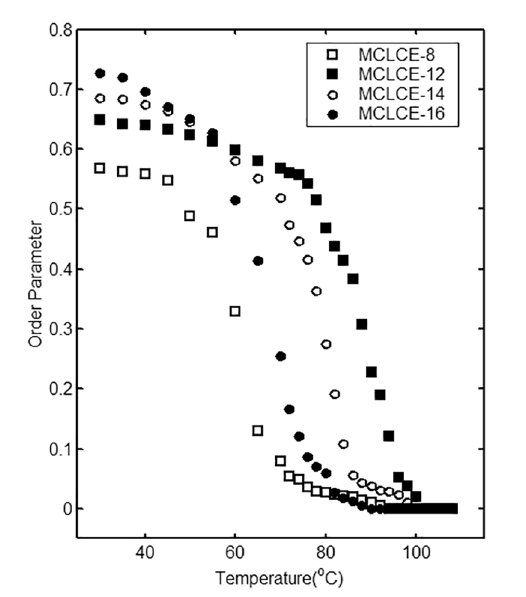
Figure 6. Order parameter dependence temperatures of MCLCEs. Each graph shows the same pattern of changing slowly at the beginning of heating and then reducing dramatically at a particular interval until the isotropic phase is